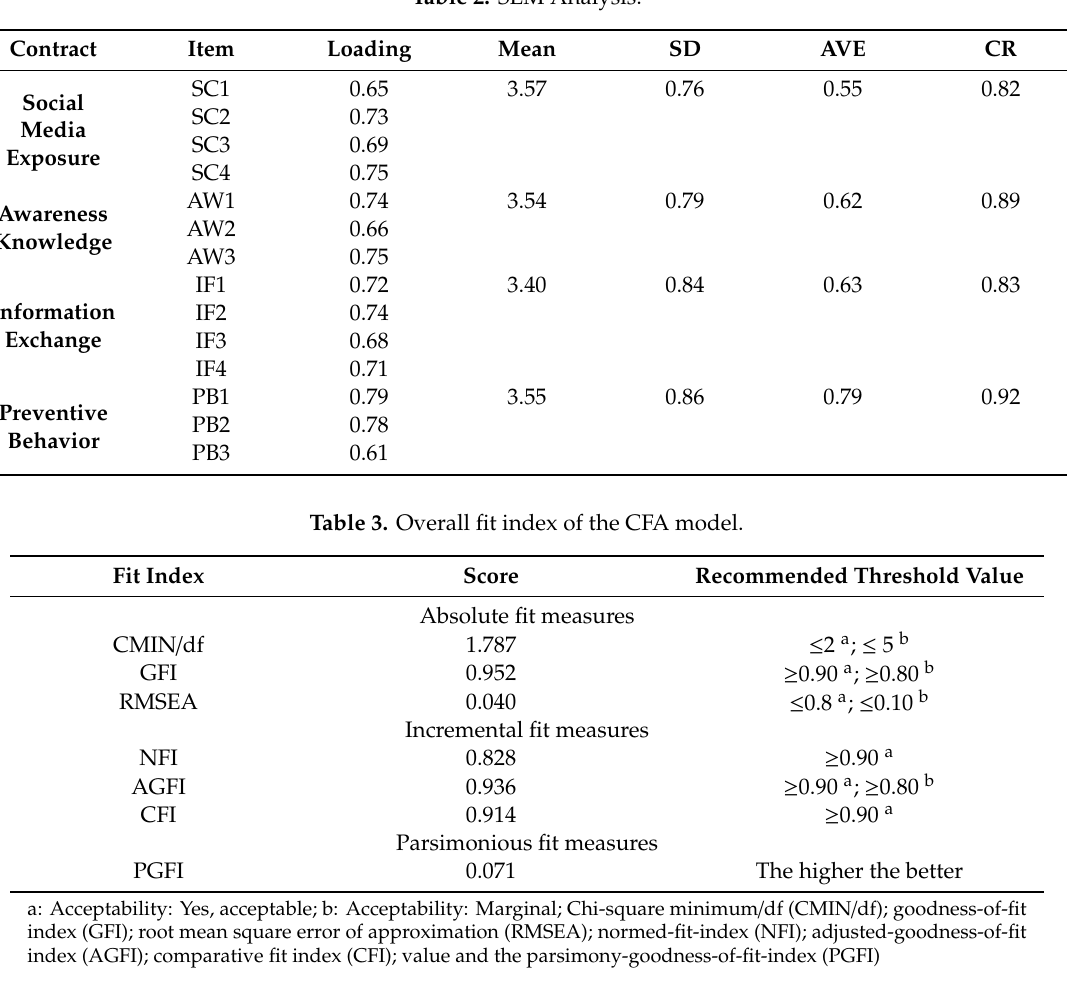
Table 2. SEM Analysis.